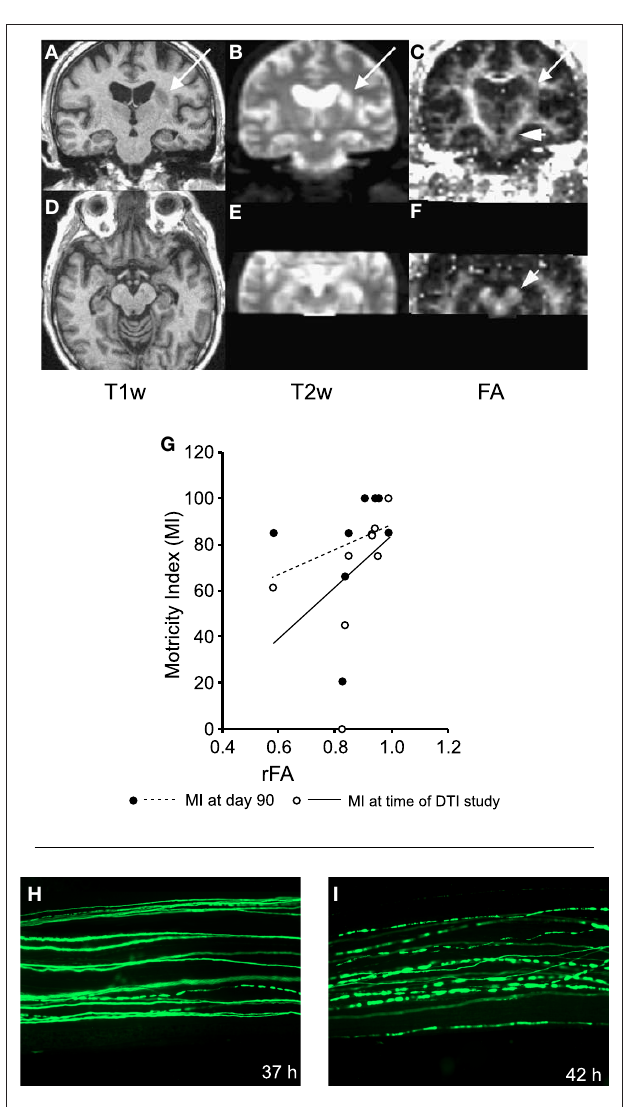
FIguRe 2 | White matter degeneration following damage. (A–g) Effects of stroke. (A–F) Coronal (top row) and axial (bottom row) MR sections taken in a patient with left striatocapsular infarction, 12 days after onset. The lesion area can be localized on T1- (A,D) and T2- (B,e) weighted scans. Fractional anisotropy (FA) is not only reduced in the lesion area, but also further along the pyramidal tract (C) and in the cerebral peduncle ( F , short arrows). (g) The fractional anisotropy ratio between affected and unaffected side (rFA) for the cerebral peduncle correlates with the Motricity Index. Individuals with a more symmetric fractional anisotropy distribution had better motor performance. (H,I) Example of Wallerian degeneration in the peripheral nervous system. The example shows Wallerian degeneration in a mouse peripheral nerve after cut injury. (H) Thirty-seven hours after cut injury with few individual fluorescent axons are broken into fragments. (I) Forty-two hours after cut injury most labeled axons appear fragmented. (A–g) Adapted with permission from Thomalla et al. (2004). (H,I) Adapted with permission from Beirowski et al.